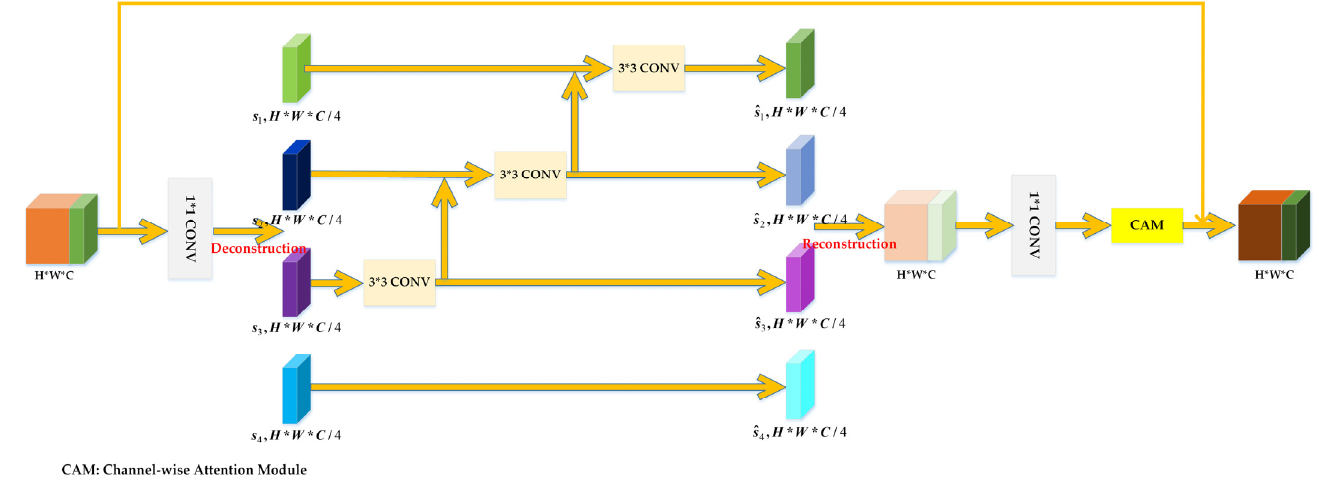
Figure 6. The structure of Deconstruction-Reconstruction.